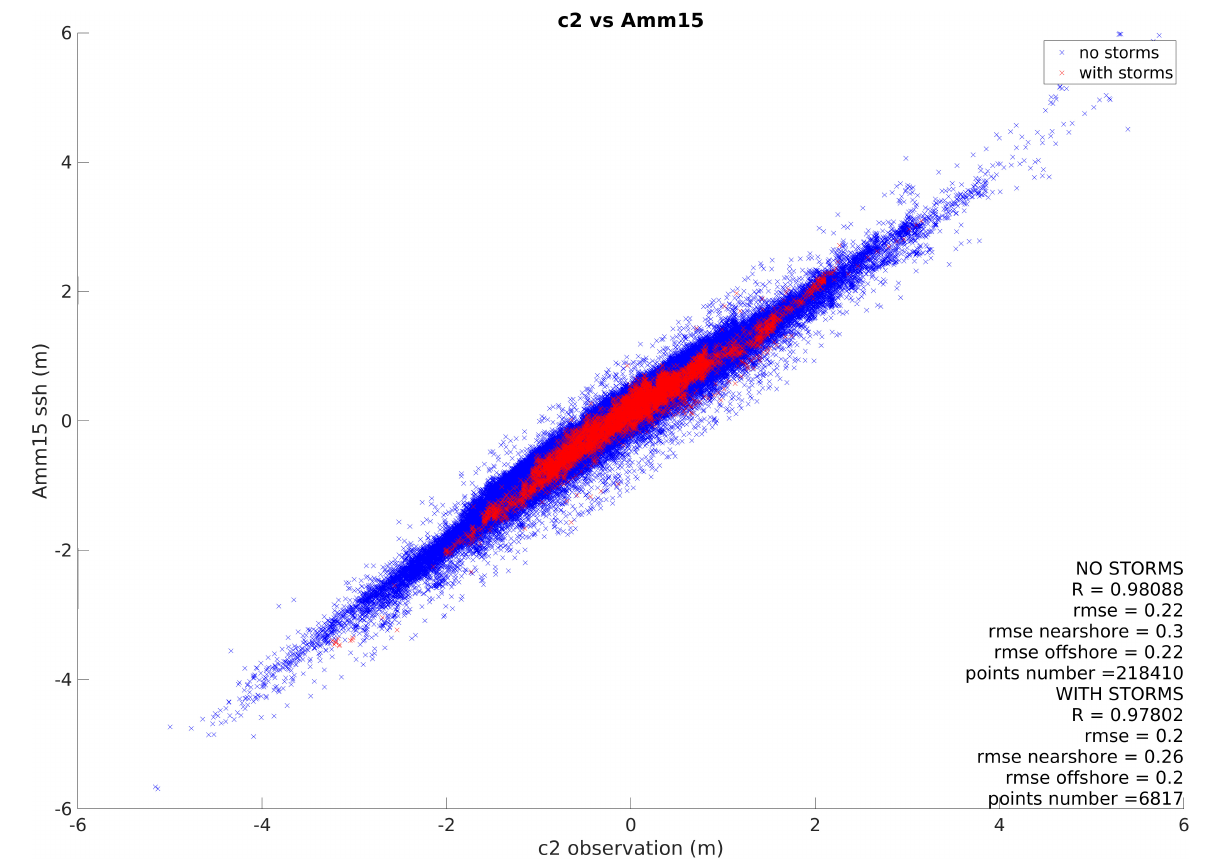
sampling means that not all storm events might be